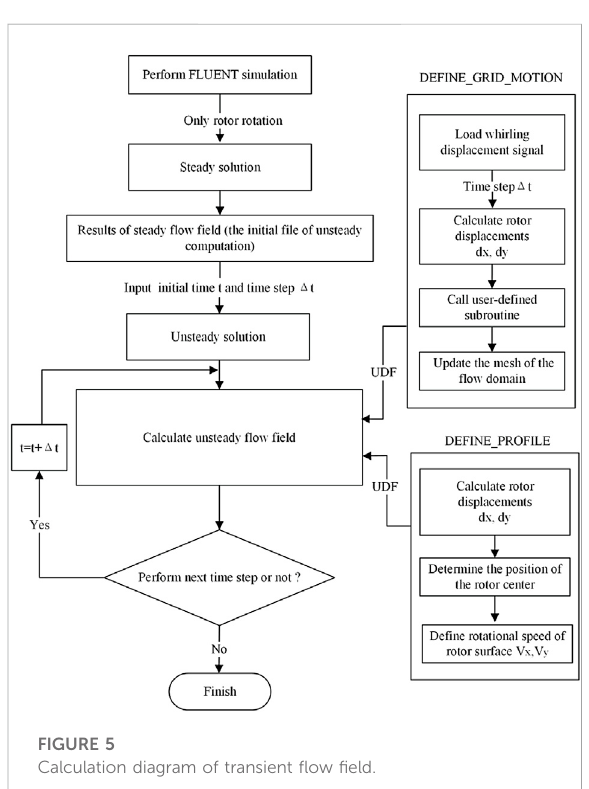
FIGURE 5 Calculation diagram of transient fl ow fi